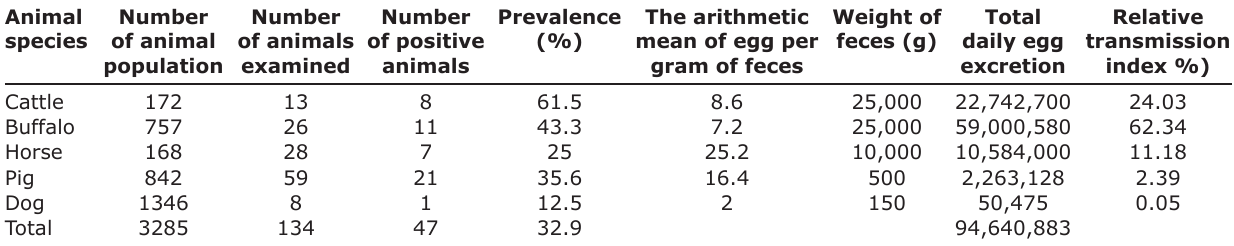
Table-3: Total daily egg excretion and relative transmission index of S. japonicum in the Subdistrict of Lindu. Animal